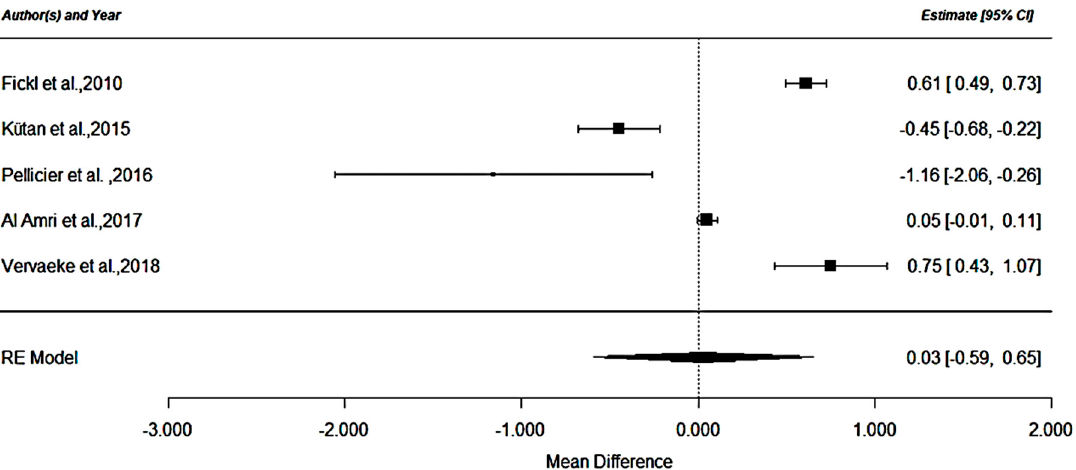
Figure 2. RCT analysis.